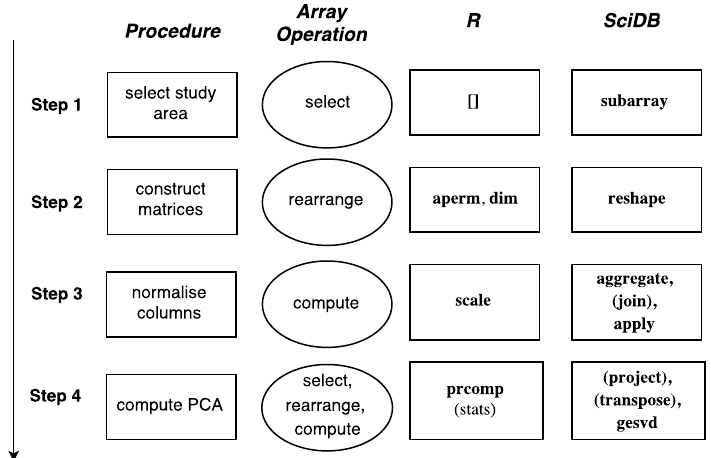
Figure 7. The procedure of the study case and the corresponding array operations, R and SciDB